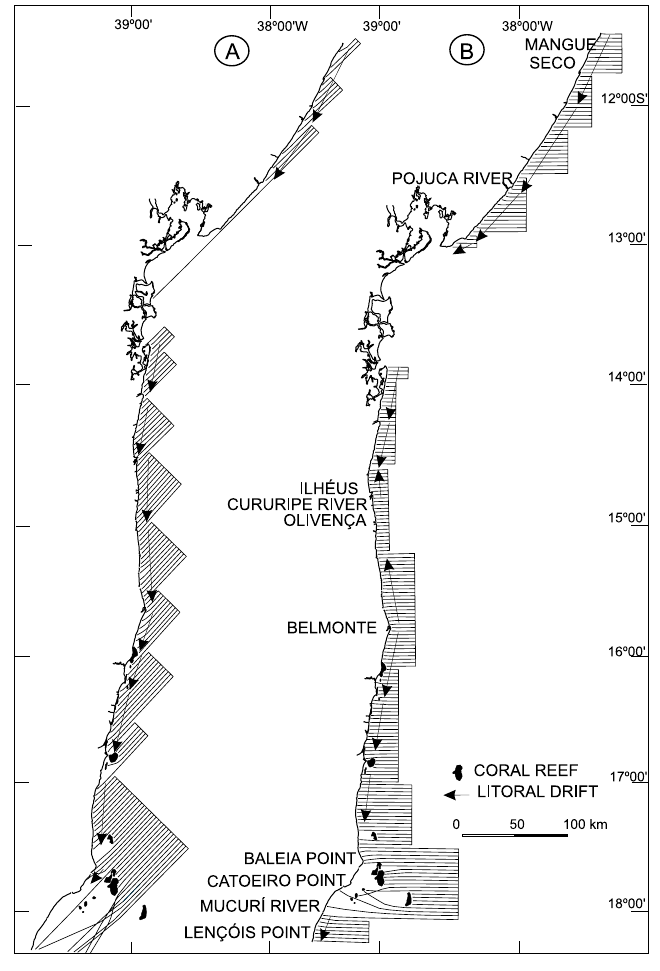
Fig. 4 – Refraction diagram for waves with 5 sec period, arising from NE (N45 ◦ ) (A) and E (N90 ◦ ) (B), referred to the coastal stretch of the State of